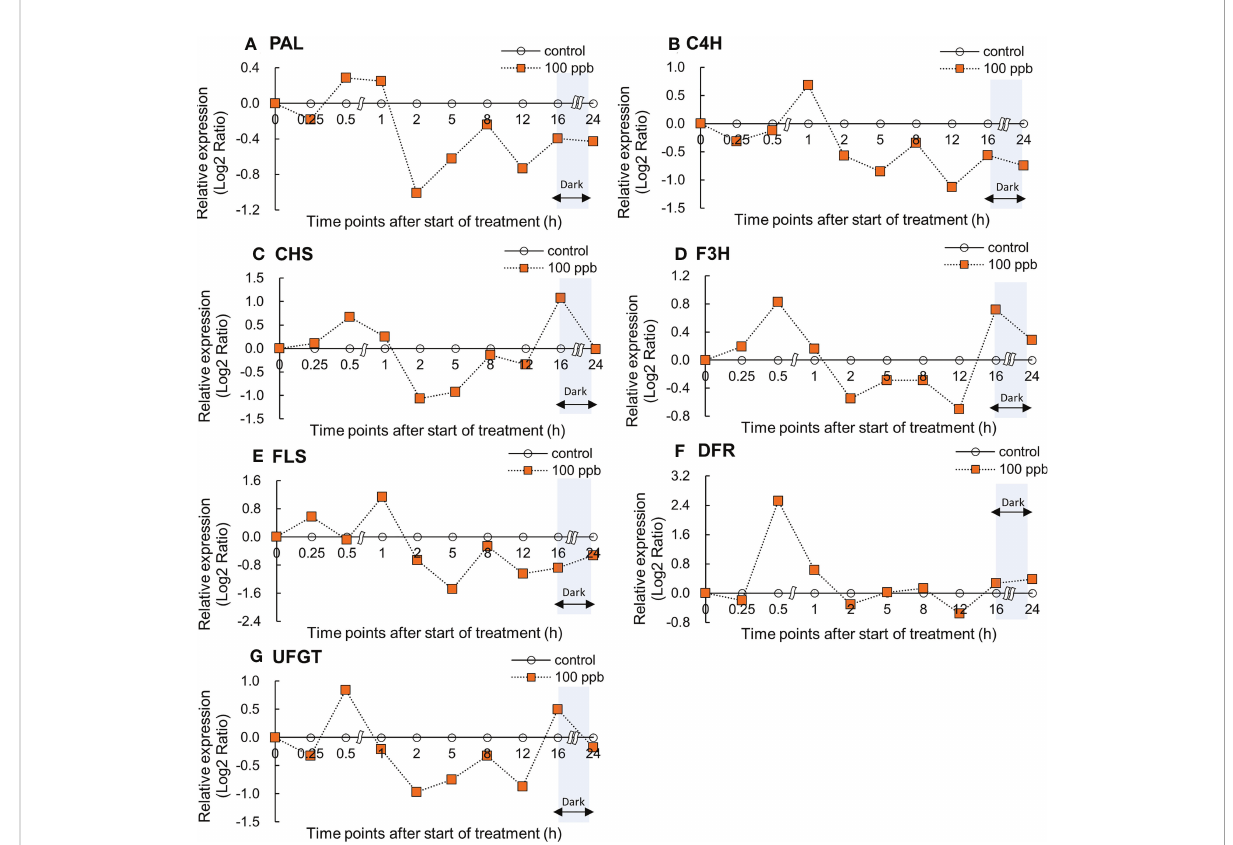
FIGURE 4 Effect of 100-ppb ozone exposure on relative gene expression (Log2 Ratio) of PAL (A) , C4H (B) , CHS (C) , F3H (D) , FLS (E) and DFR (F) , and UFGT (G) mRNA in fourth leaf of lettuce plant. The vertical vars indicate SE (n=4). The line graphs indicate Log2 fold change (treatment/control) levels of gene